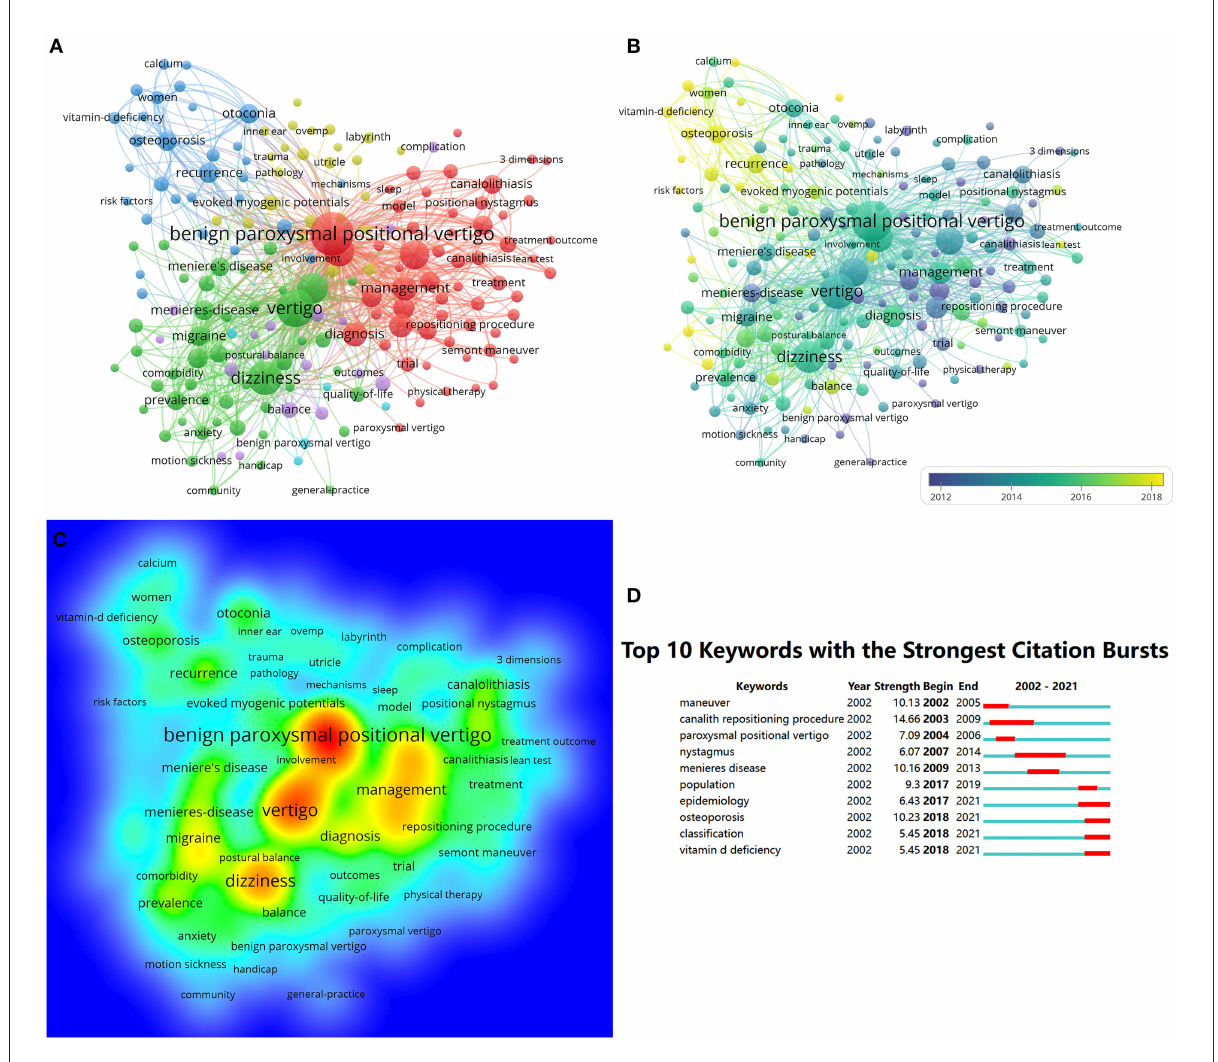
FIGURE5 (A) A network diagram of 181 keywords classified into five clusters. (B) The distribution of keywords is shown in the order of their appearance. (C) The density visualization map of the keywords. (D) The top-10 keywords with the largest citation bursts (2002–2021).